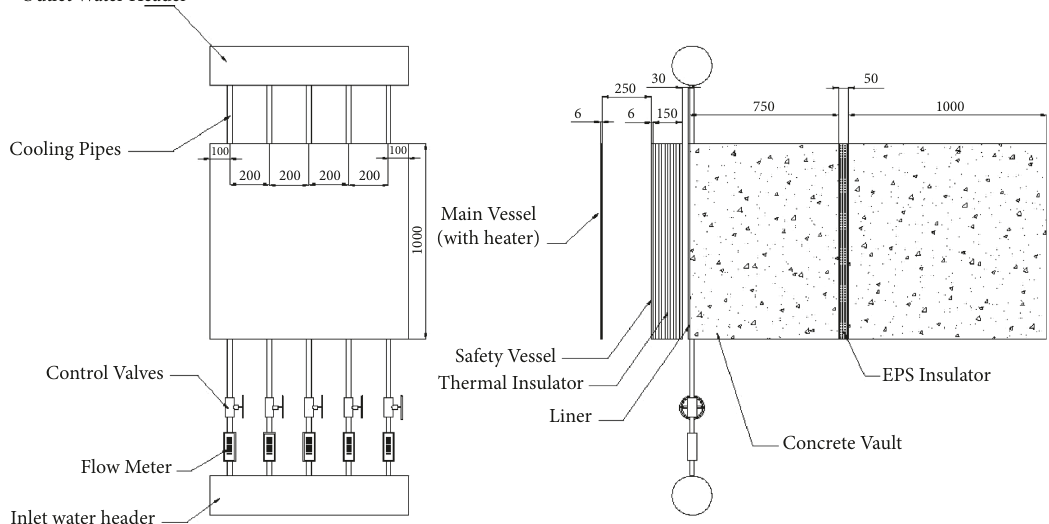
Figure 14: Concrete reactor vault.